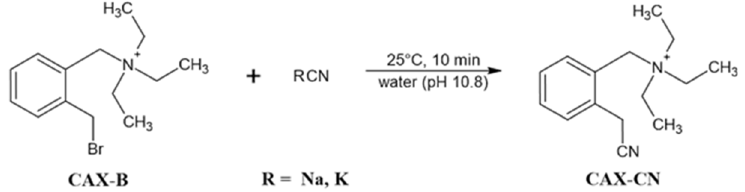
Figure 9. Reaction scheme of cyanide derivatization by N -(2-(bromomethyl)benzyl)- N , N - diethylethanaminium bromide (CAX-B).